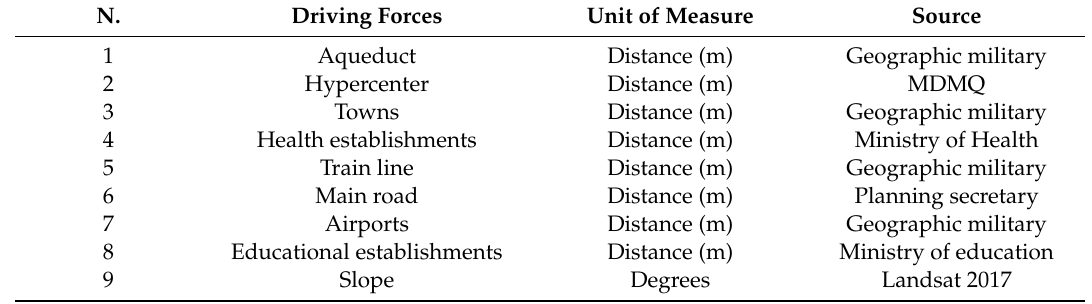
Table 4. Driving Forces.